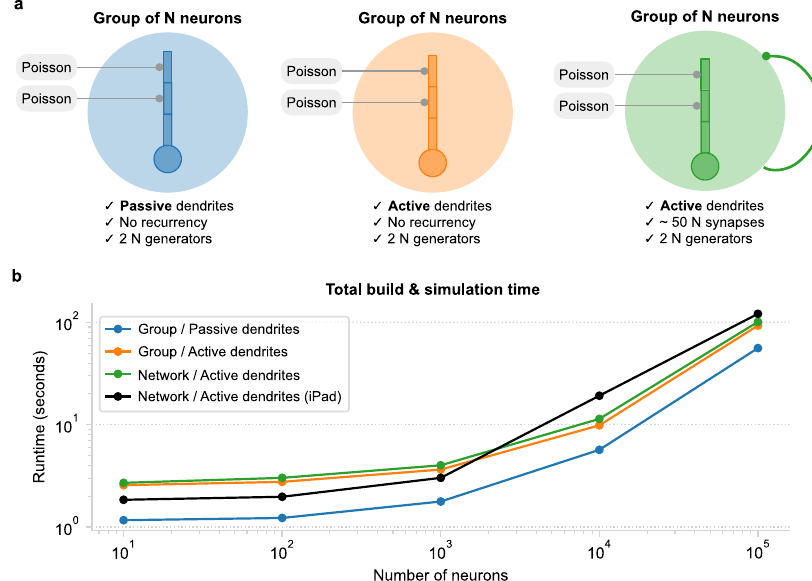
Fig. 6 | Estimating Dendrify ’ s performance for increasing network complexity and size. a Schematic illustration of the three model cases used for the scalability analysis. In all cases, the neuronal model was an adapted version of the four- compartment model shown in Fig. 2a. Note that the number of Poisson input generatorsscaled with N . Left: a group of N neurons with passive dendrites and no recurrent synapses. Middle: a group of N neurons with active dendrites (i.e., furn- ishedwithNa+dSpikes)andnorecurrentsynapses.Right:arecurrentnetworkof N